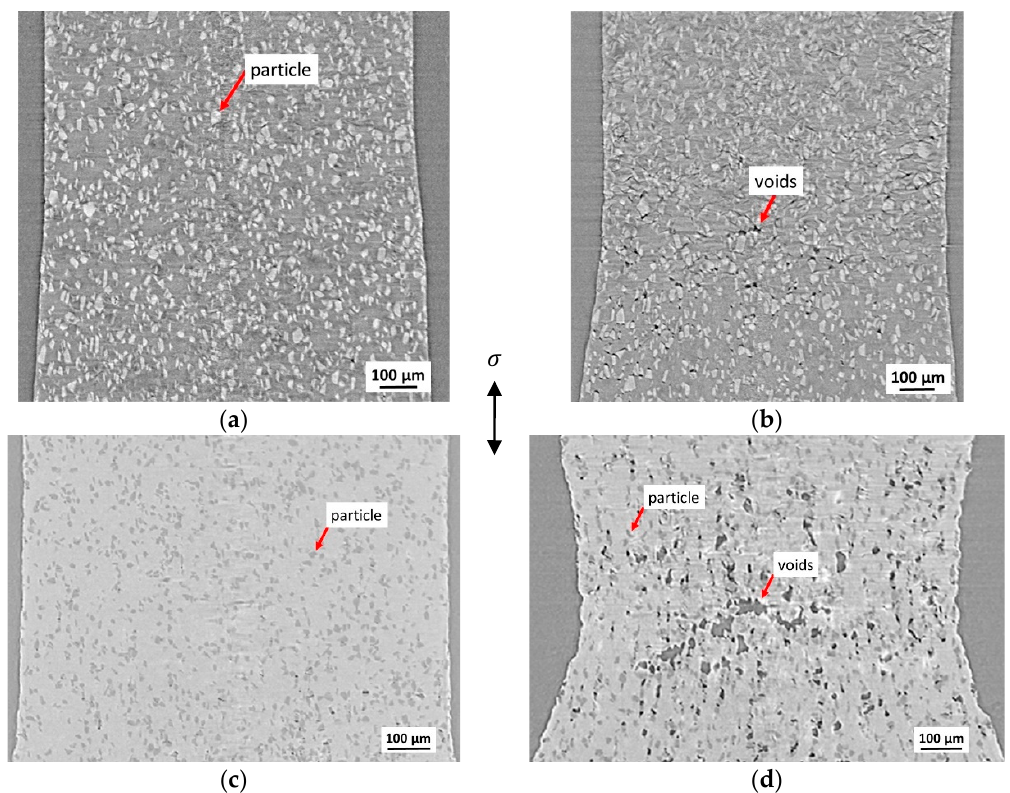
Figure 16. Tomogram, 2D longitudinal section, contraction during creep: ( a ) Al-MMC, 𝜎 = 50 MPa, 𝑇 = 300 °C, initial state; ( b ) Al-MMC, 𝜎 = 50 MPa, 𝑇 = 300 °C at 0.996 𝑡 (cid:3033)(cid:3045) ; ( c ) Ti-MMC, 𝜎 = 150 T = 300 ◦ C, initial state; ( b ) Al-MMC, σ = 50 MPa, T = 300 ◦ C at 0.996 t fr ; ( c ) Ti-MMC, σ = 150 MPa, MPa, 𝑇 = 510 °C at 0.77 𝑡 (cid:3033)(cid:3045) ; (d) Ti-MMC, 𝜎 = 150 MPa, 𝑇 = 510 °C at 0.99 𝑡 (cid:3033)(cid:3045) . T = 510 ◦ C at 0.77 t fr ; (d) Ti-MMC, σ = 150 MPa, T = 510 ◦ C at 0.99 t fr